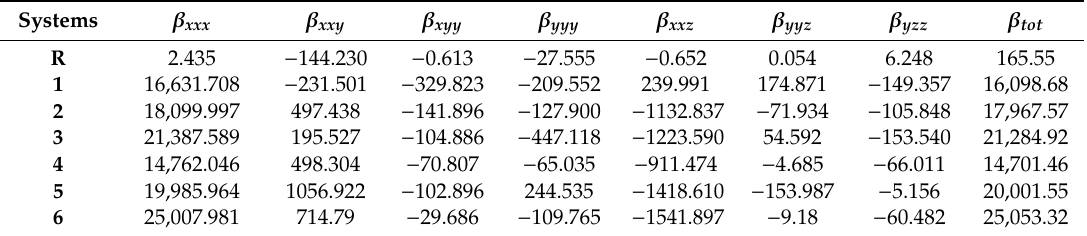
Table 7. The computed second-order polarizabilities ( β tot ) and major contributing tensors (a.u.) of R and 1 – 6 in solvent (DMSO) at the CAM-B3LYP / 6-31G(d,p) level of